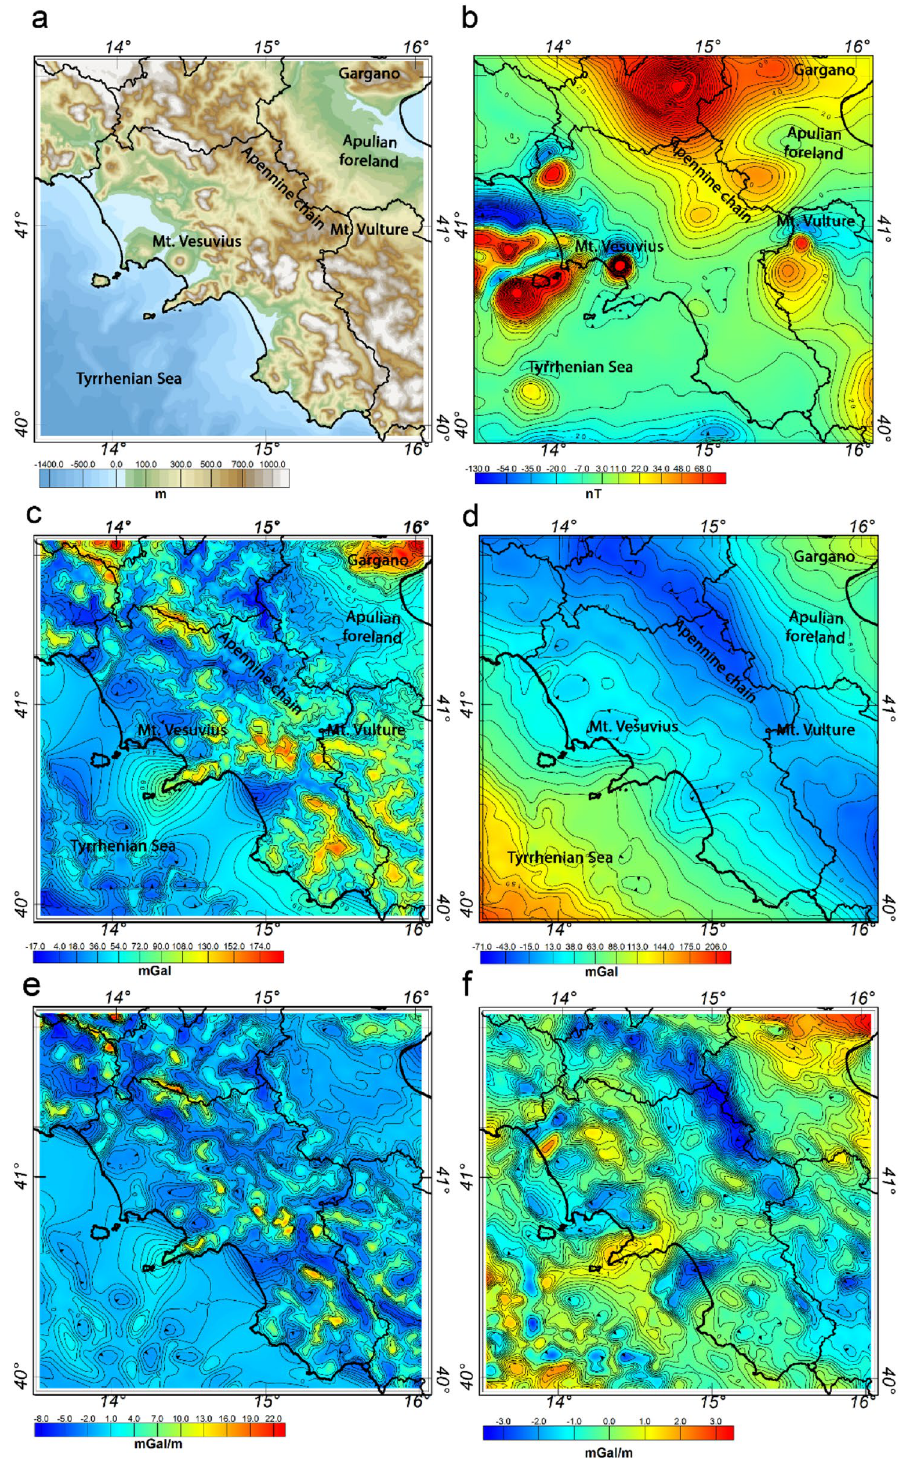
Figure 2. Maps of the topography of southern Italy ( a ); the aeromagnetic field map ( b ); Free-air ( a ) and Bouguer ( b ) gravity field maps and the vertical gradient of the Free-air ( c ) and Bouguer gravity field. The maps were generated using the Oasis Montaj Geosoft software (v.9.9.1.34 https:// www. seequ ent. com/ produ cts- solut ions/ geoso ft- oasis-